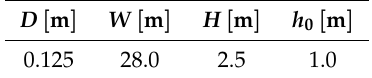
Table 1. Input parameters for model